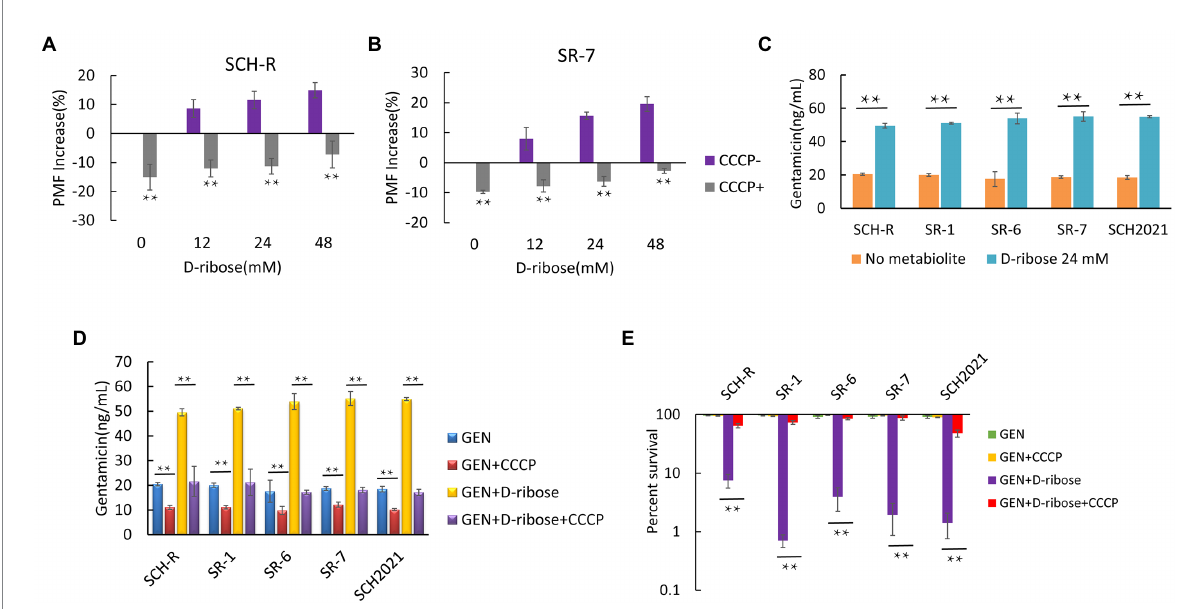
FIGURE 5 Effect of exogenous D-ribose on membrane potential. (A) Variation of PMF in SCH-R by D-ribose dose with or without CCCP. (B) Variation of PMF in SR-7 by D-ribose dose with or without CCCP. (C) Intracellular concentration of gentamicin in SCH-R and clinical isolates in the presence of 24 mM D-ribose. (D) Intracellular concentration of gentamicin in SCH-R and clinical isolates in the presence of 24 mM D-ribose with or without CCCP. GEN, gentamicin. (E) Percent survival of SCH-R and clinical isolates in the presence or absence of CCCP and 1 MIC gentamicin plus 24 mM D-ribose. GEN, gentamicin. Results are displayed as the mean ± SEM and three biological repeats are carried out. Significant differences are identified ( *p < 0.05 and **p <